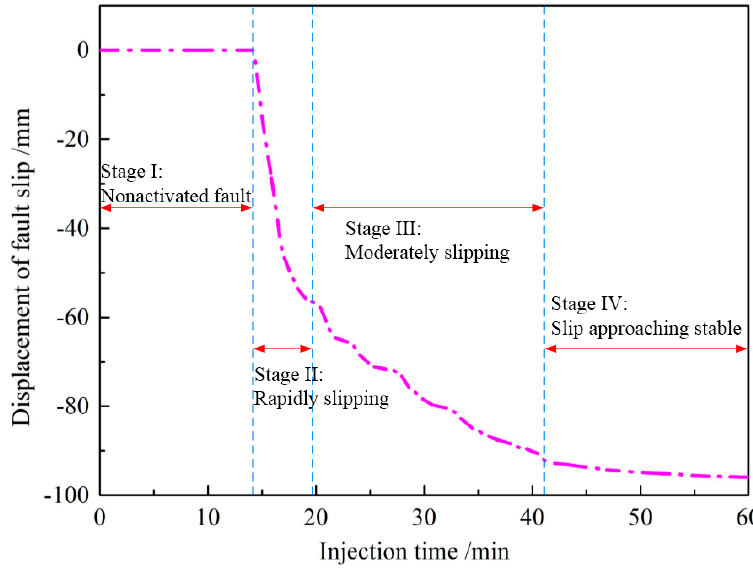
Figure 11. A representative curve for fault slip displacement.